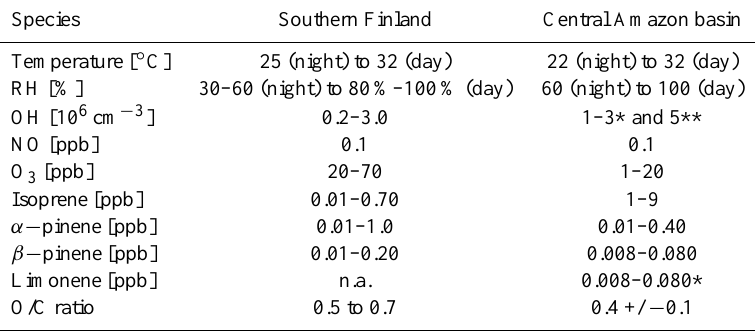
Table 1. Range of concentrations of temperature, relative humidity, OH, O 3 various monoterpenes, and O/C ratio relevant in Southern Finland and the central Amazon